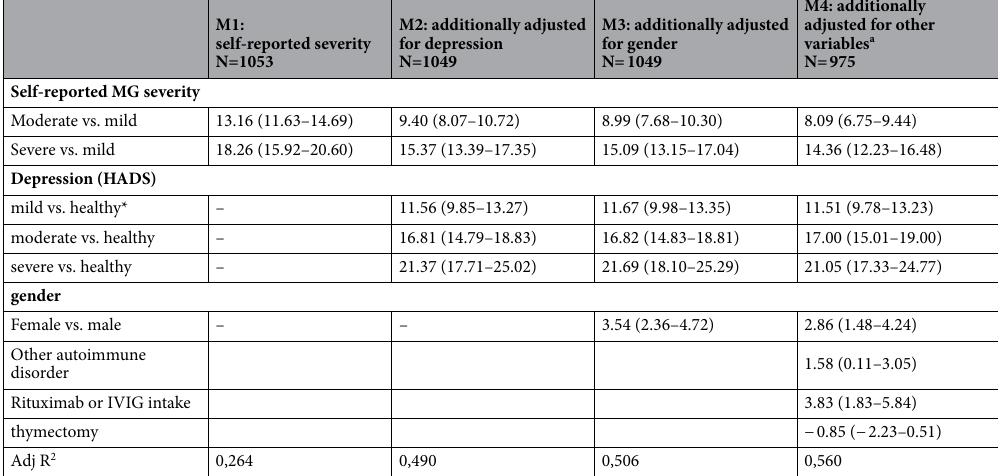
Table 3. Associations between self-reported MG severity and MGQOL15 scale scores (z-transformed continuous outcome). Stepwise Linear regression analysis. Estimated marginal means with 95%CI for MGQOL15 scale scores. *healthy = no depression according to HADS. a M4: Additionally adjusted for